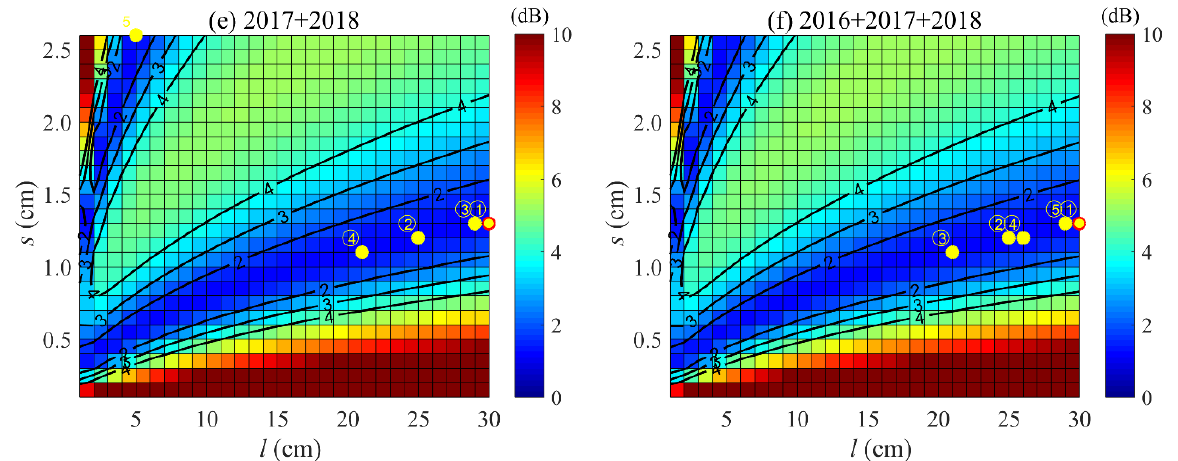
Figure 3. Distribution of RMSE S1_AIEM between the Sentinel-1A backscatter and AIEM simulation computed at different temporal scales: ( a ) 2016, ( b ) 2017, ( c ) 2018, ( d ) 2016+2017, ( e ) 2017+2018, and ( f ) 2016+2017+2018. The black lines represent the contours. The yellow circles indicate the five small- est RMSE S1A_AIEM , and the circle with red edge is the final selected effective roughness parameters.